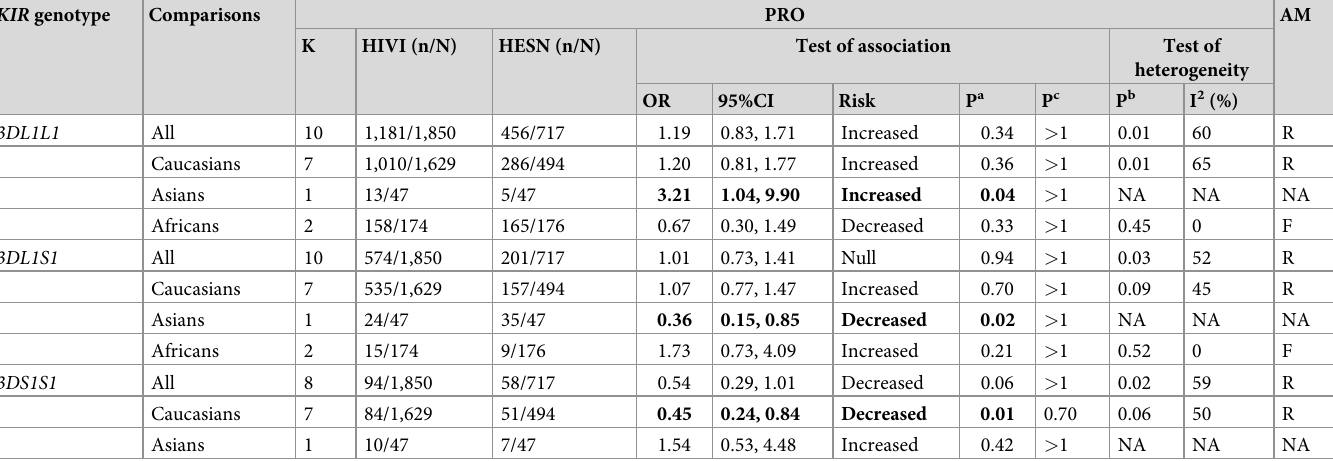
treatments. Between the two polymorphisms, 2DL3 presents strong evidence on account of the magnitude of protective effect (81%), associative and interaction outcomes (P ci < 10 − 4 ). On the other hand, 3DS1S1 is strong based on number of studies and aggregate statistical power (Table 6). The advantage or disadvantages of using sensitivity approach versus eliminating the outlier is contextualized in terms of the following: Sensitivity treatment evaluates robustness of the pooled ORs while outlier elimination addresses heterogeneity. Favorable outcome of sensi- tivity analysis is robustness, where no study contributed to instability of the results. On the other hand, favorable outcomes of outlier treatment involve both heterogeneity and signifi- cance. In our study, heterogeneity was either reduced or eliminated; significance was Table 3. Summary associations of 3DL1/S1 genotypes and HIV acquisition in the pre-outlier (PRO) analysis. KIR genotype Comparisons PRO AM K HIVI (n/N) HESN